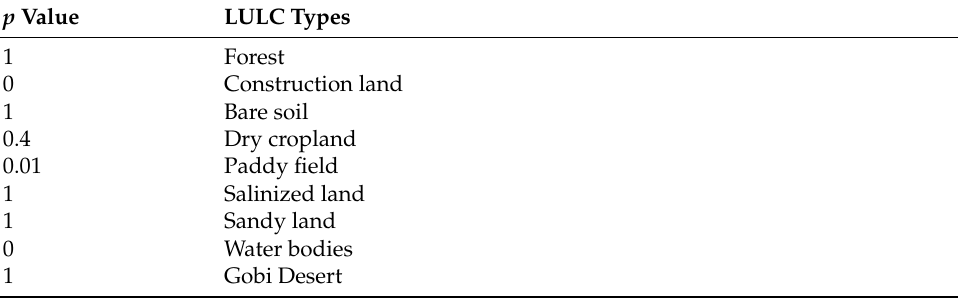
Table 2. Soil conservation practice factors based on LULC in the